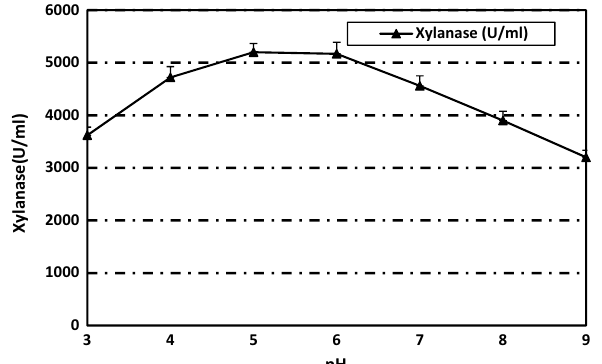
Figure 5. pH stability of the purified xylanase from Paecilomyces variotti.